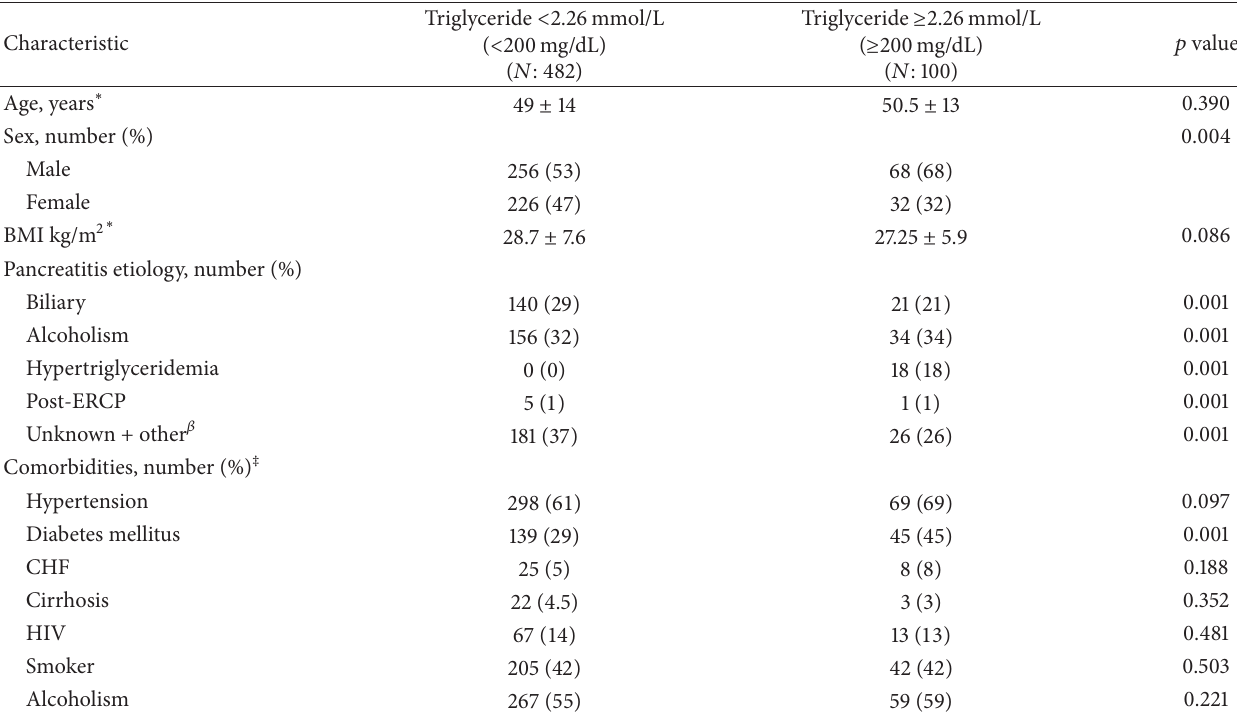
Table 1: Population baseline